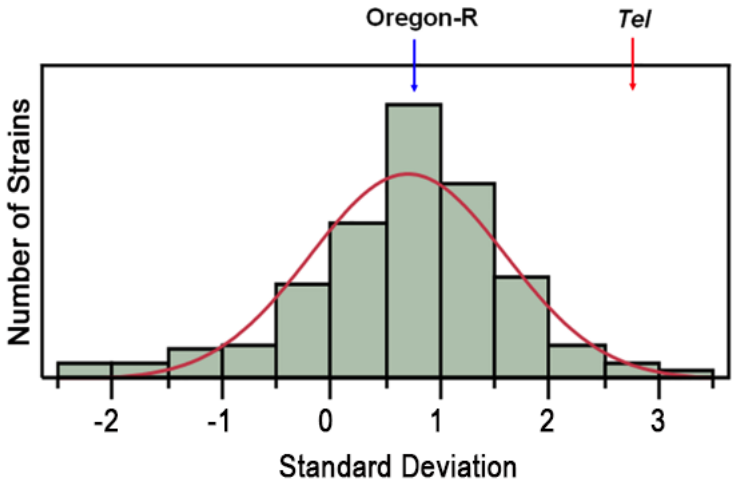
Figure 4. Telomere lengths in DGRP lines. A bar graph shows the log-normal distribution of telomere lengths among the 162 DGRP lines measured. The blue arrow shows the position of the Oregon-R control, and the red arrow shows the position of Tel 1 . Three lines have Het-A copy numbers that exceed three standard deviations from the mean. These are RAL-161, -703, and -882. The red curve indicates the expected distribution.